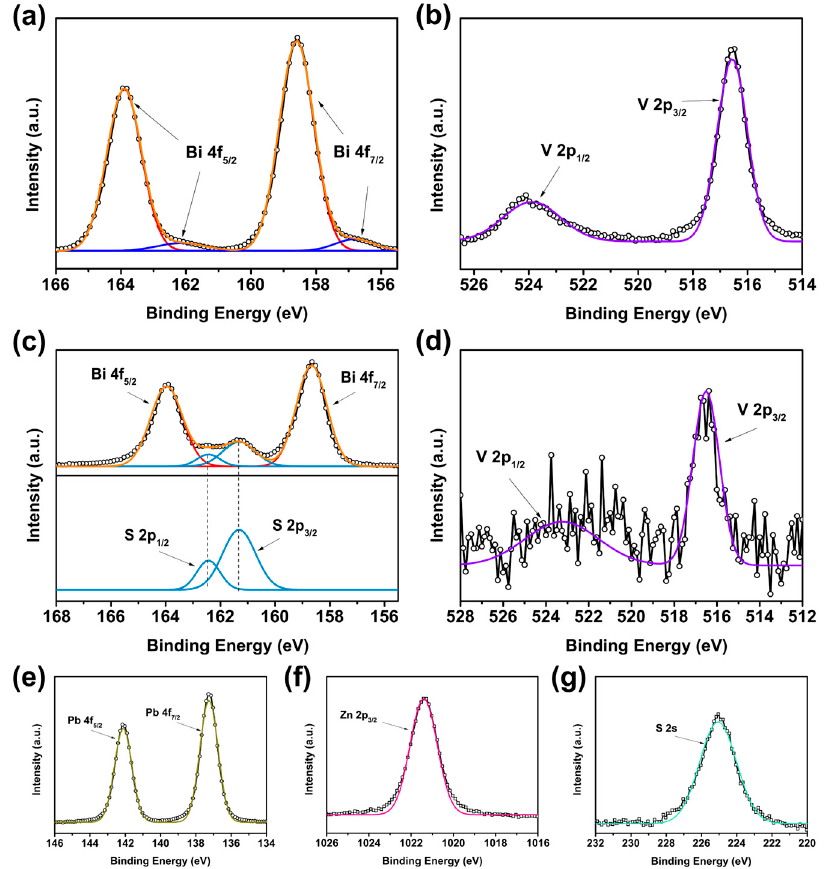
Figure 5. High-resolution XPS spectra of ( a ) Bi 4f and ( b ) V 2p for bare BiVO 4 film. ( c ) Bi 4f and S 2p, ( d ) V 2p, ( e ) Pb 4f, ( f ) Zn 2p 3/2 , and ( g ) S 2s for BiVO 4 /PbS QDs/ZnS film.